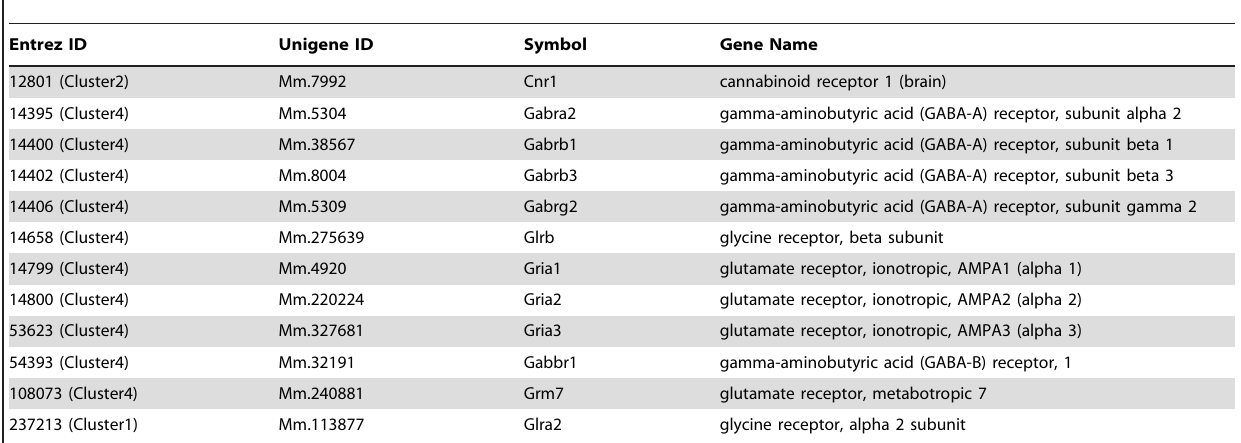
Table 8. Twelve strong candidate biomarker genes for mouse brain